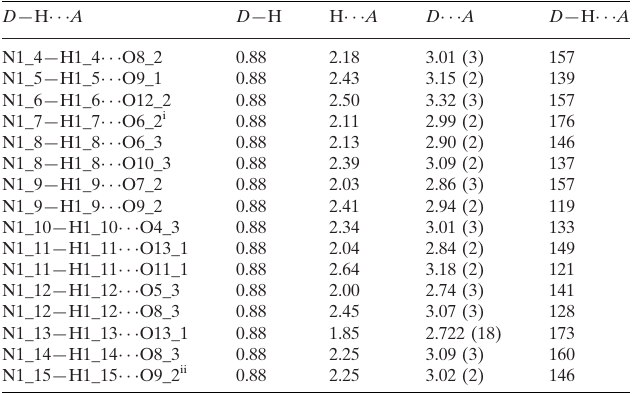
Hydrogen-bond geometry (A˚ , (cid:3) ).